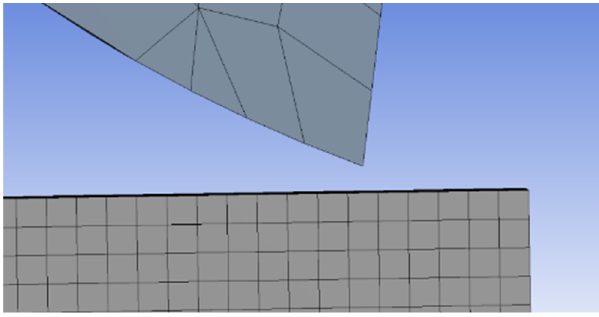
Figure 3. Cutting Tool with Workpiece—tool before contour engagement.